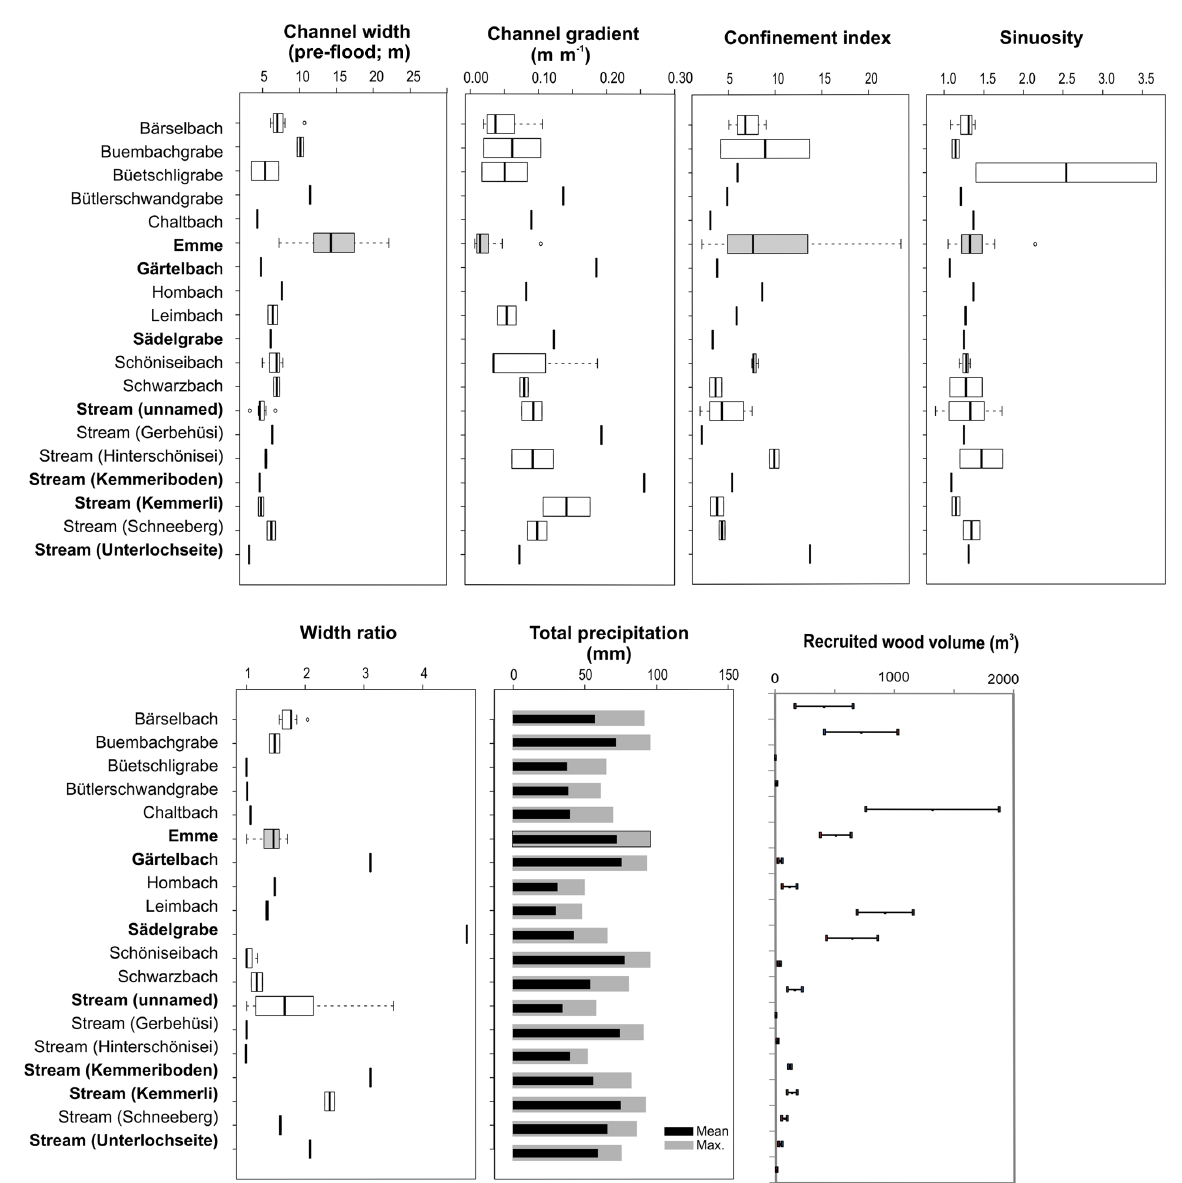
Figure 3. Box plots of averaged initial channel width (before the flood), channel gradient, confinement ratio, sinuosity, width ratio, pre- cipitation, and recruited wood volumes for the 19 studied streams. Total maximum and mean total precipitation are calculated based on the 1km precipitation grid cells in the respective catchments (maximum shows the highest value, mean shows the mean value recorded in each sub-catchment). Recruited wood volumes are given in ranges based on forest density ranges (as explained in the Methods section). In bold are the streams highlighted in Fig.